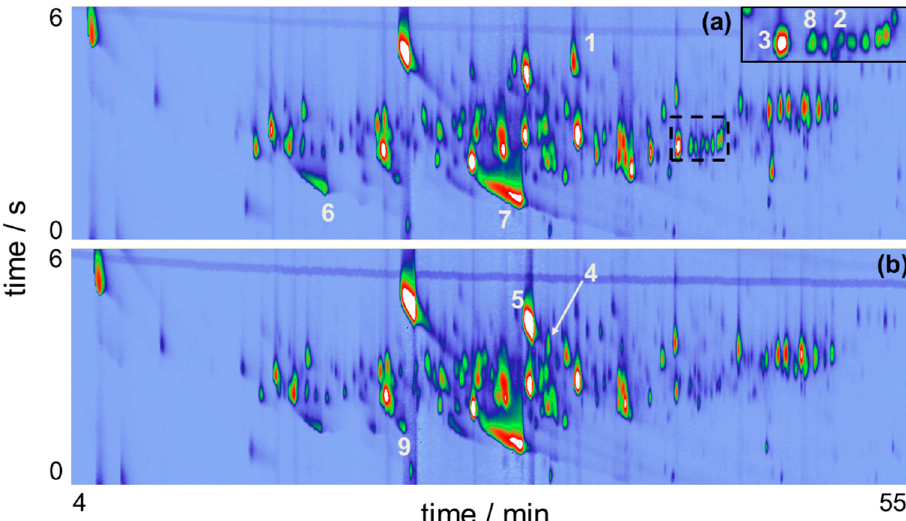
Figure 2. GC×GC-QMS chromatograms for two craft beer samples using HS-SPME and sampling with DVB/CAR/PDMS ( a ) BR sample; ( b ) ENG sample. BR corresponds to the beer brewed with the Brazilian Ale 02 yeast and ENG corresponds to the beer brewed with the Nottingham yeast.